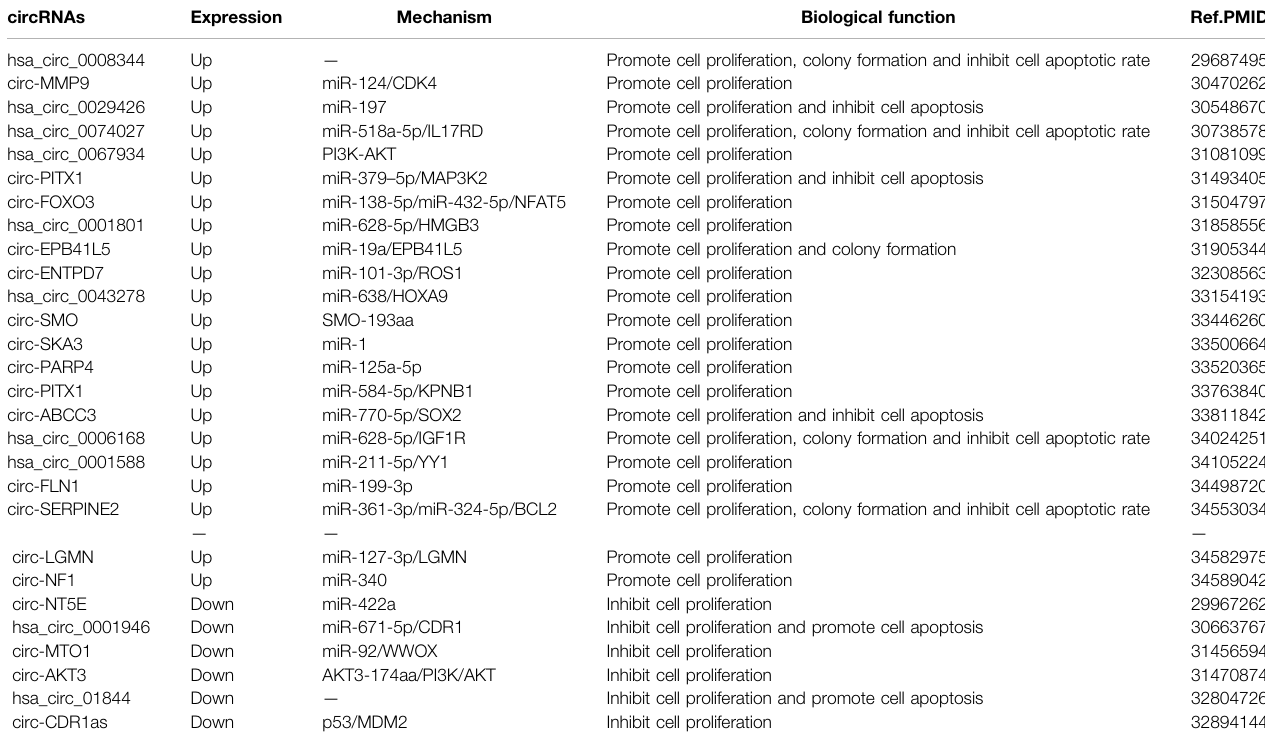
TABLE 1 | The proliferation-related circular RNAs in GBM.